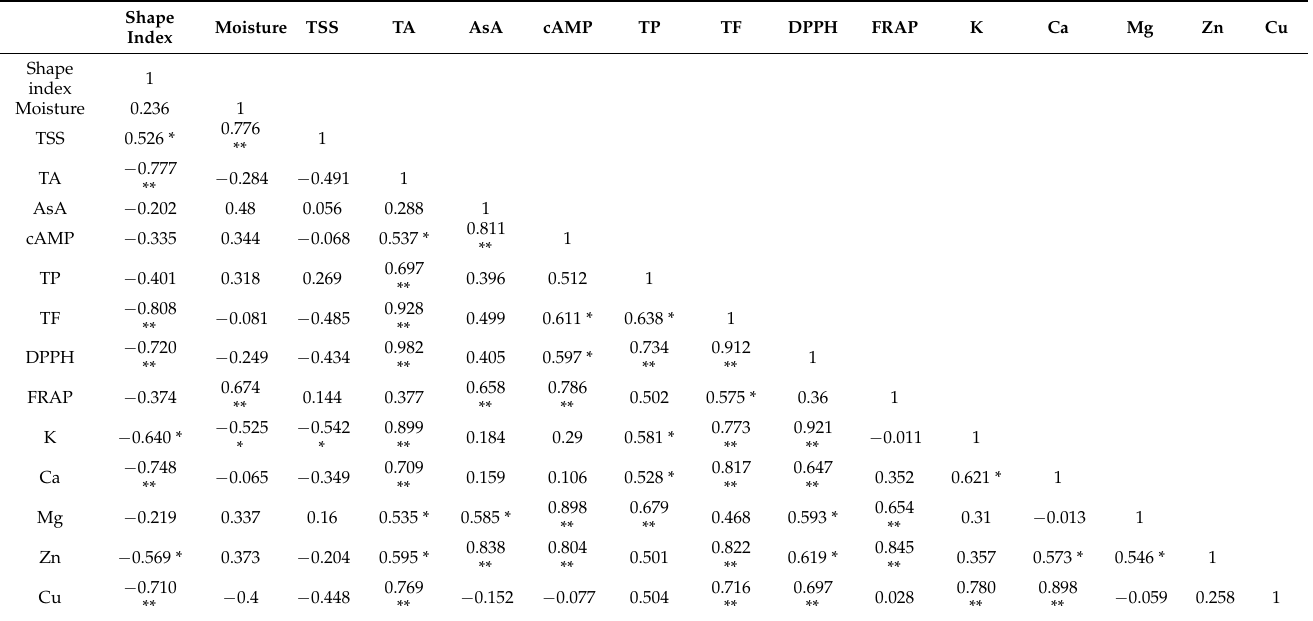
Table 3. The correlation analysis of dried